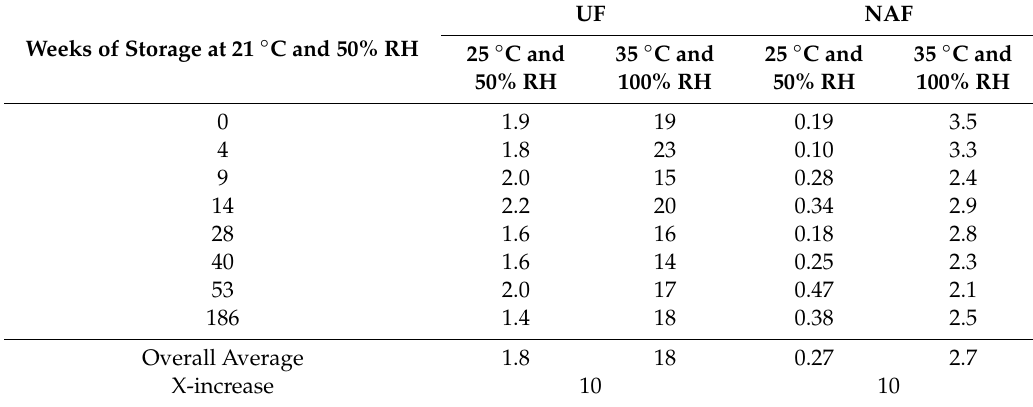
Table 3. Formaldehyde emissions (ug / g dry wood) as a function of storage time.